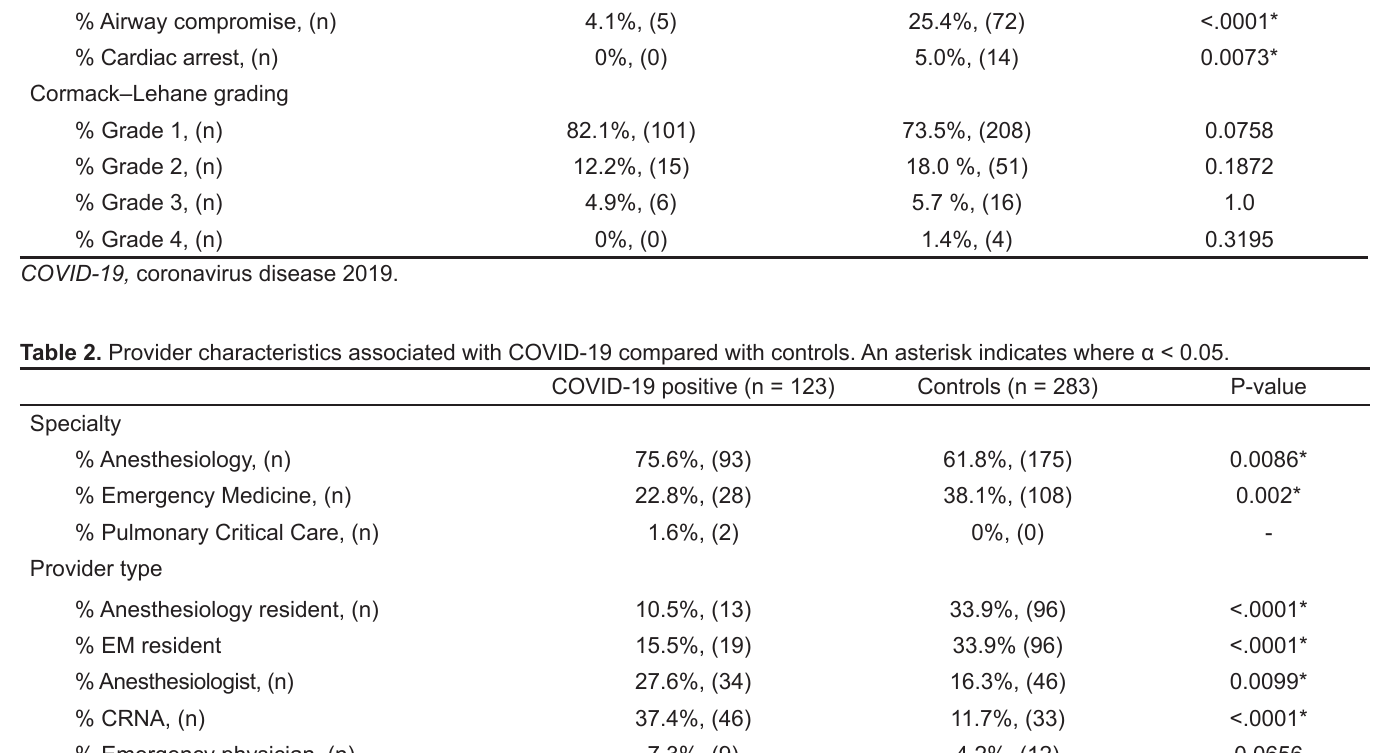
COVID-19, coronavirus disease 2019; EM, emergency medicine; CRNA, certified registered nurse anesthetist